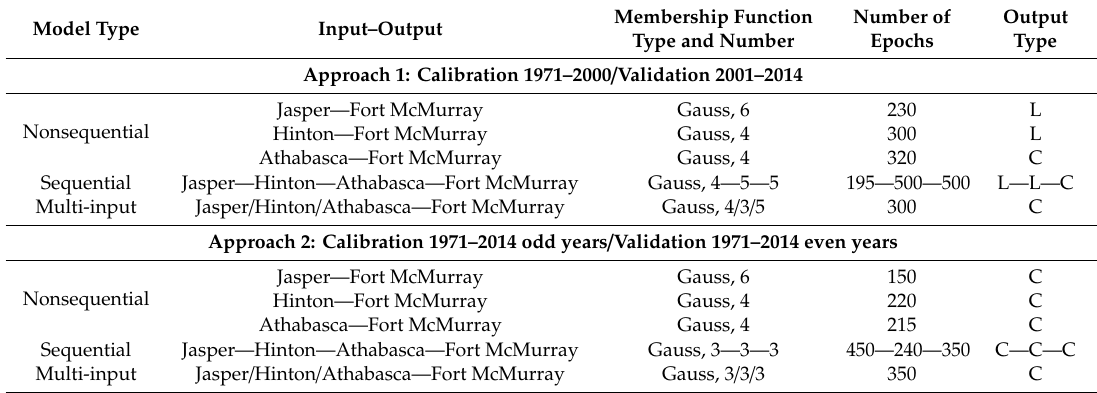
* L = linear, C = constant.